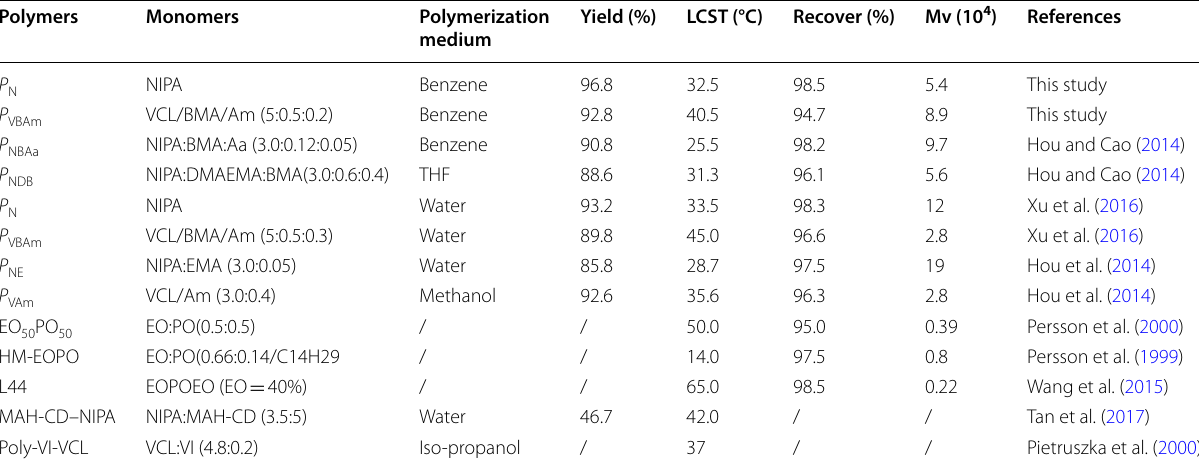
“/” means that no corresponding information can be found in the published paper